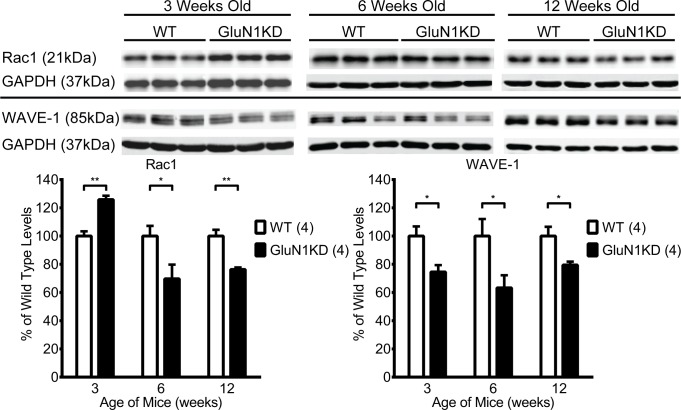
Representative western blots (top) and their quantifications (bottom) assessing differences in Rac1 and WAVE-1 levels at the striatum of male and female GluN1KD mice and WT littermates aged 3, 6, and 12 weeks. In GluN1KD mice, Rac1 was significantly increased at 3 weeks before decreasing to lower than WT levels at 6 and 12 weeks of age. In contrast, WAVE-1 was consistently decreased at all time points. All blots were first normalized to GAPDH loading controls. A sample size of 4 mice per group, denoted in the graph legends beside genotype labels, was used for every genotype and age group. Data was analyzed by two-tailed, independent t-tests, * p ≤ 0.05, ** p < 0.01.